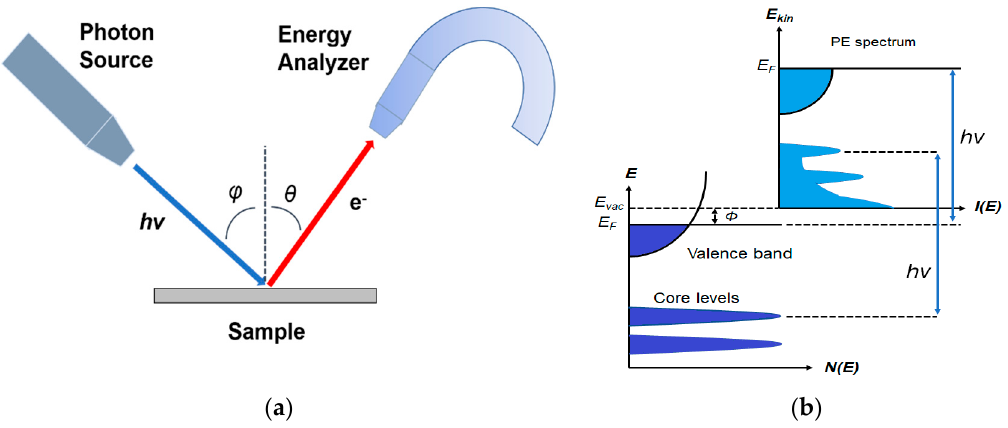
Figure 1. ( a ) Schematic of a photoemission experiment. ( b ) Schematic representation of photoemission spectroscopy (PES). From Ref. [47] with permission.